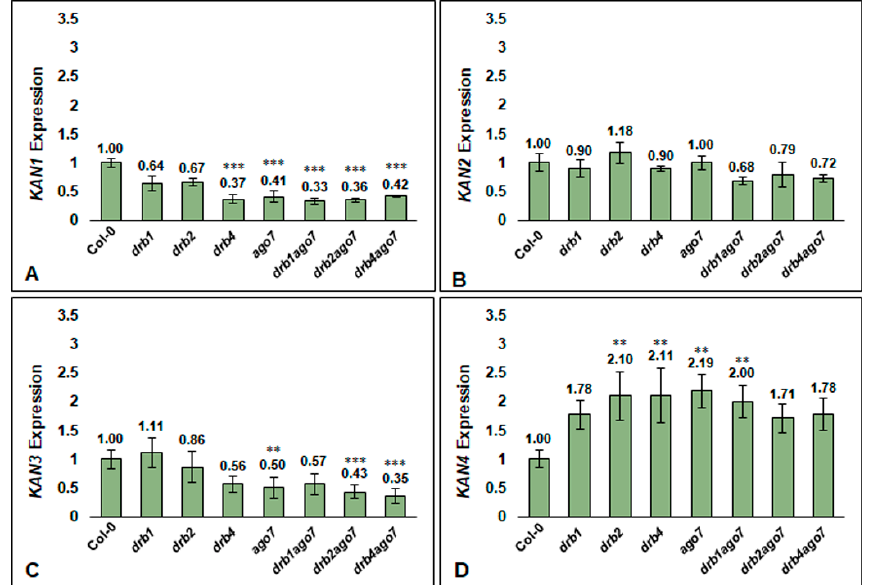
Figure 5. Quantification of the expression of the KANADI transcription factors, KAN1 , KAN2 , KAN3 , and KAN4 in Arabidopsis floral tissues. The expression of the KAN1 ( A ), KAN2 ( B ) , KAN3 ( C ), and KAN4 ( D ) transcription factor genes was quantified in the terminal floral buds of 42-day-old Col-0, drb1 , drb2 , drb4 , ago7 , drb1ago7 , drb2ago7, and drb4ago7 plants by RT-qPCR. Error bars represent the standard error of the mean of the four biological replicates assessed for each plant line. The fold change in expression relative to Col-0 plants is presented above each column. The presence of an asterisk above a column represents a statistically significant difference between the mutant plant line and Col-0 plants ( p -value: * < 0.05; ** < 0.005; *** < 0.001).